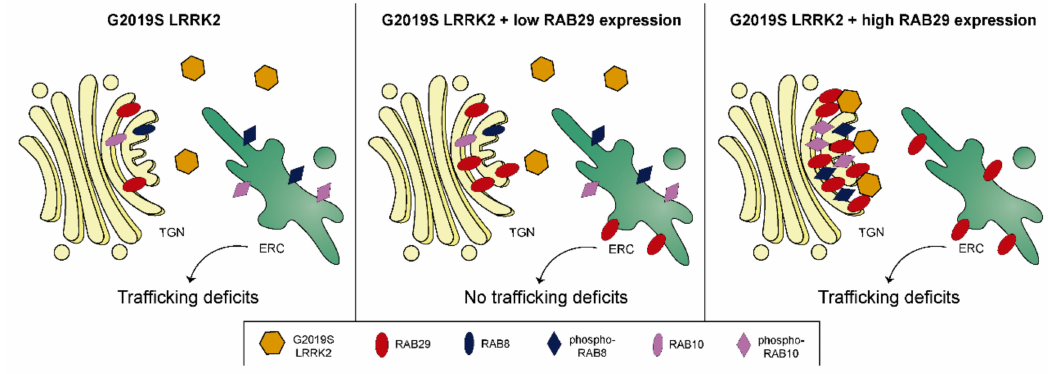
Figure 8. Model for the RAB29-mediated regulation of G2019S LRRK2 localization and rescue